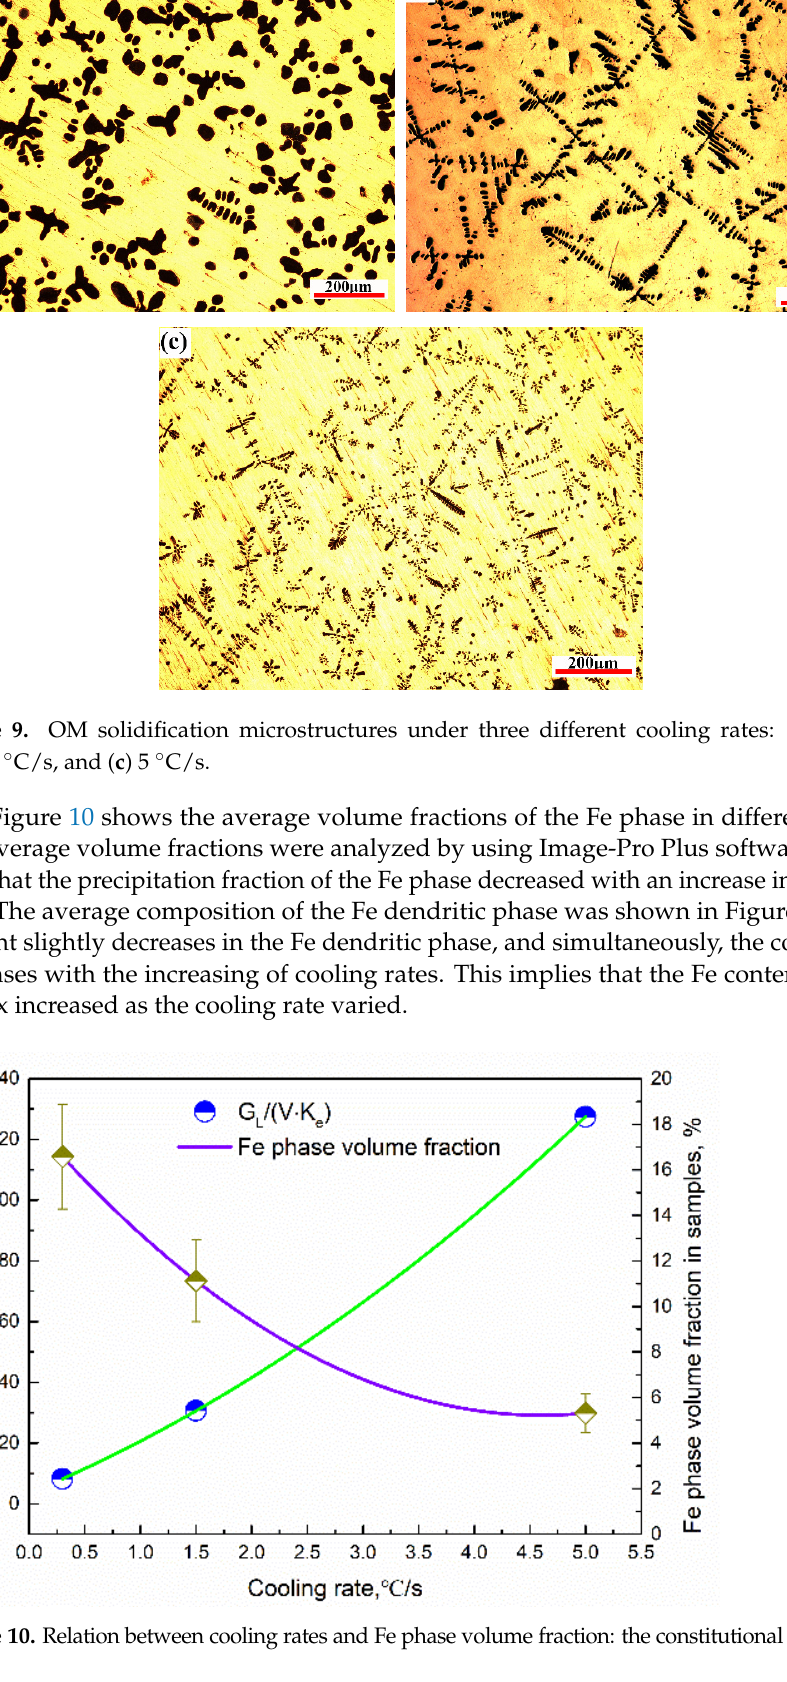
Figure 10. Relation between cooling rates and Fe phase volume fraction: the constitutional undercooling.